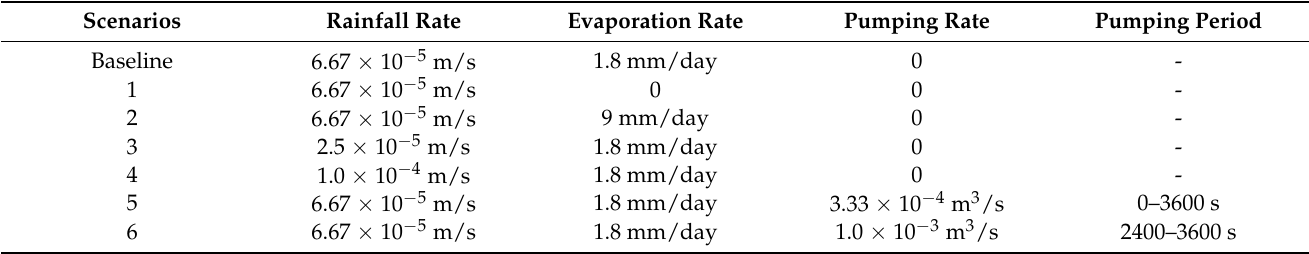
Table 6. A summary of scenarios in the groundwater-surface water modeling in the DYK case.